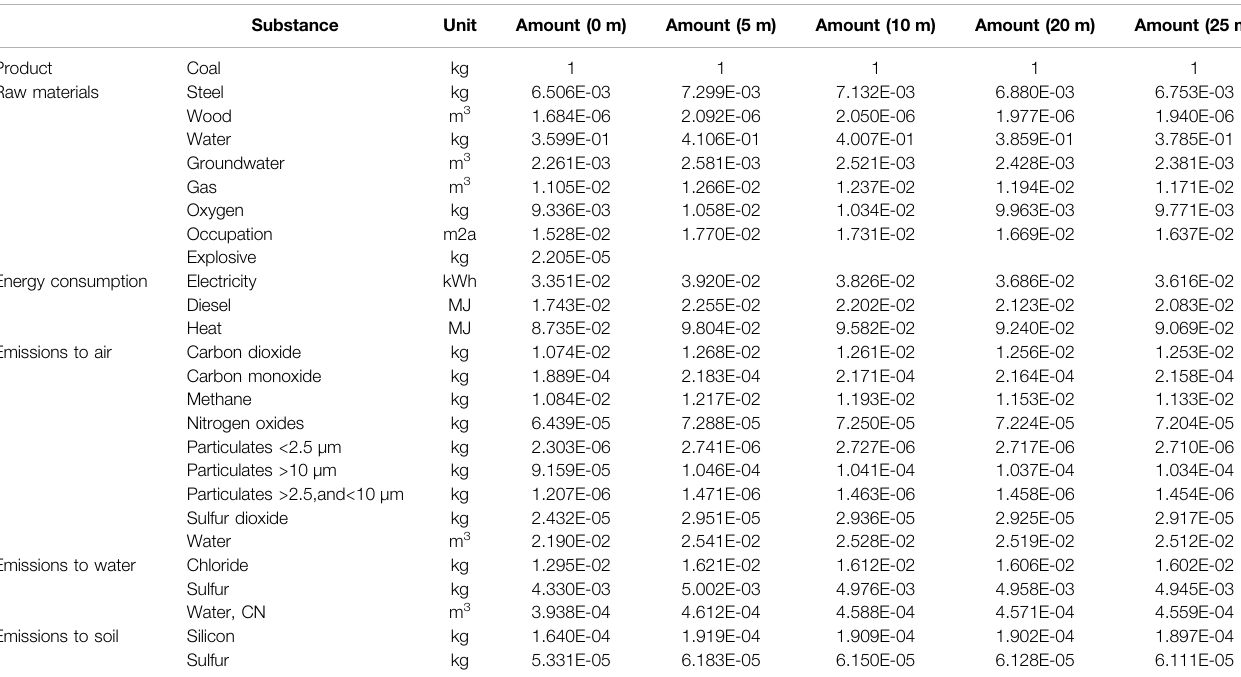
TABLE 1 | Life cycle inventory (Values were presented per functional